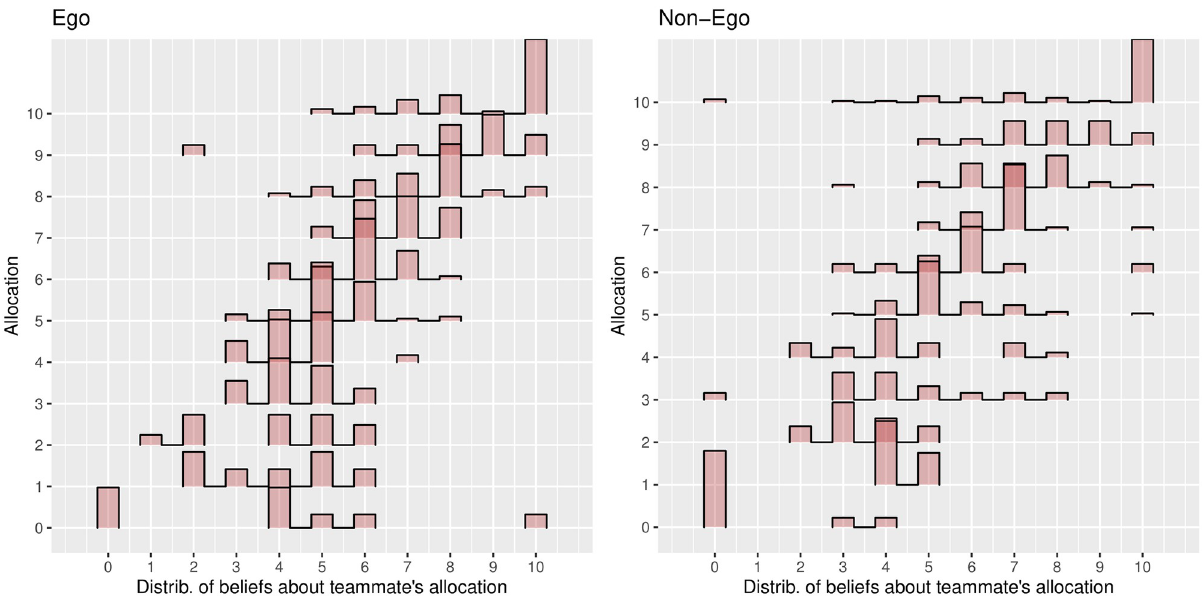
Fig 2. Effort contribution levels conditional on belief about teammate’s contribution. Panels correspond to ego-relevance treatment.